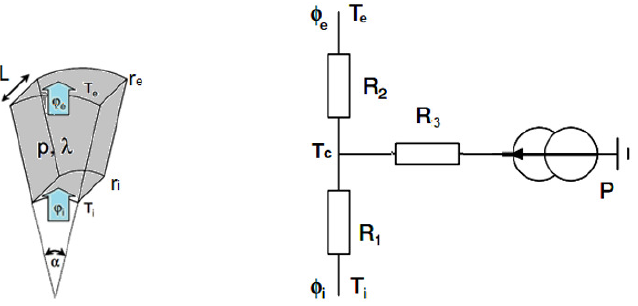
Figure 5. Basic model of a cylinder portion with the T nodal method. R 1 , R 2 are thermal radial resistances of an element of a cylinder, and R 3 is a